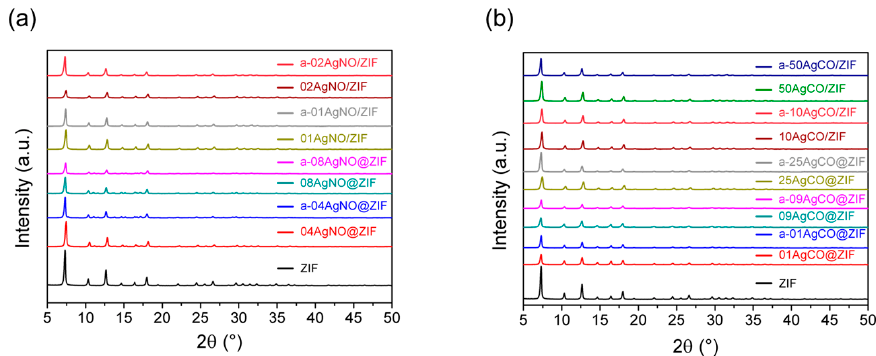
Figure 11. The XRD patterns of ( a ) de novo- and ( b ) impregnation-synthesized Ag(I)@ZIF-8 with different loading amounts of AgNO 3 and Ag 2 CO 3 salts before and after the silver-release experiment.